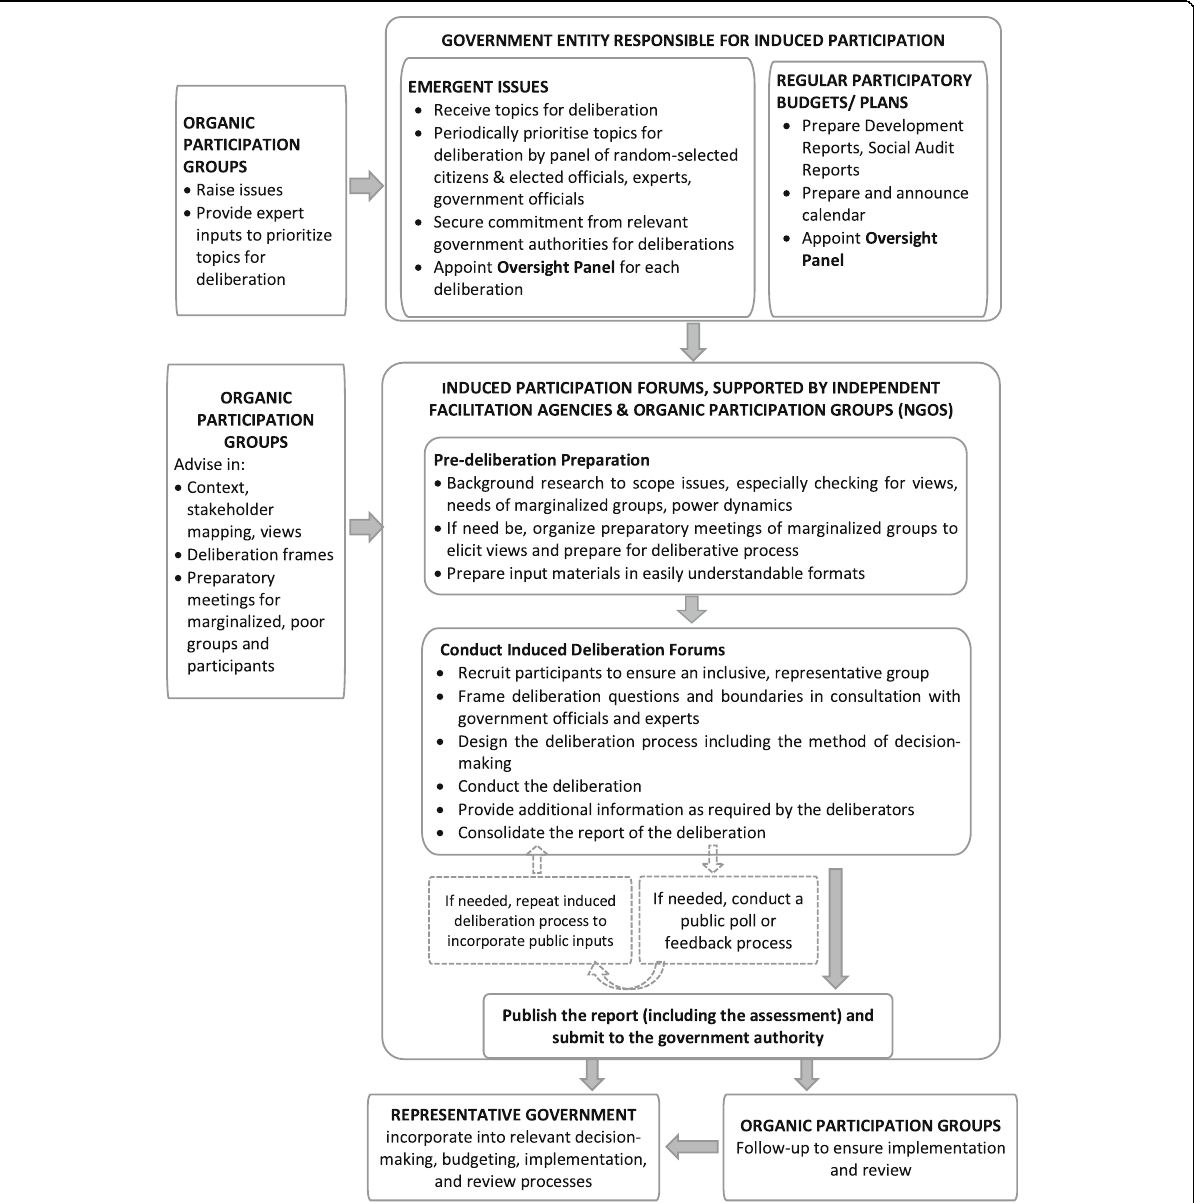
Fig. 1 Process flow chart on key steps for high quality public deliberation with organic and induced participation characteristics, facilitated by an independent third